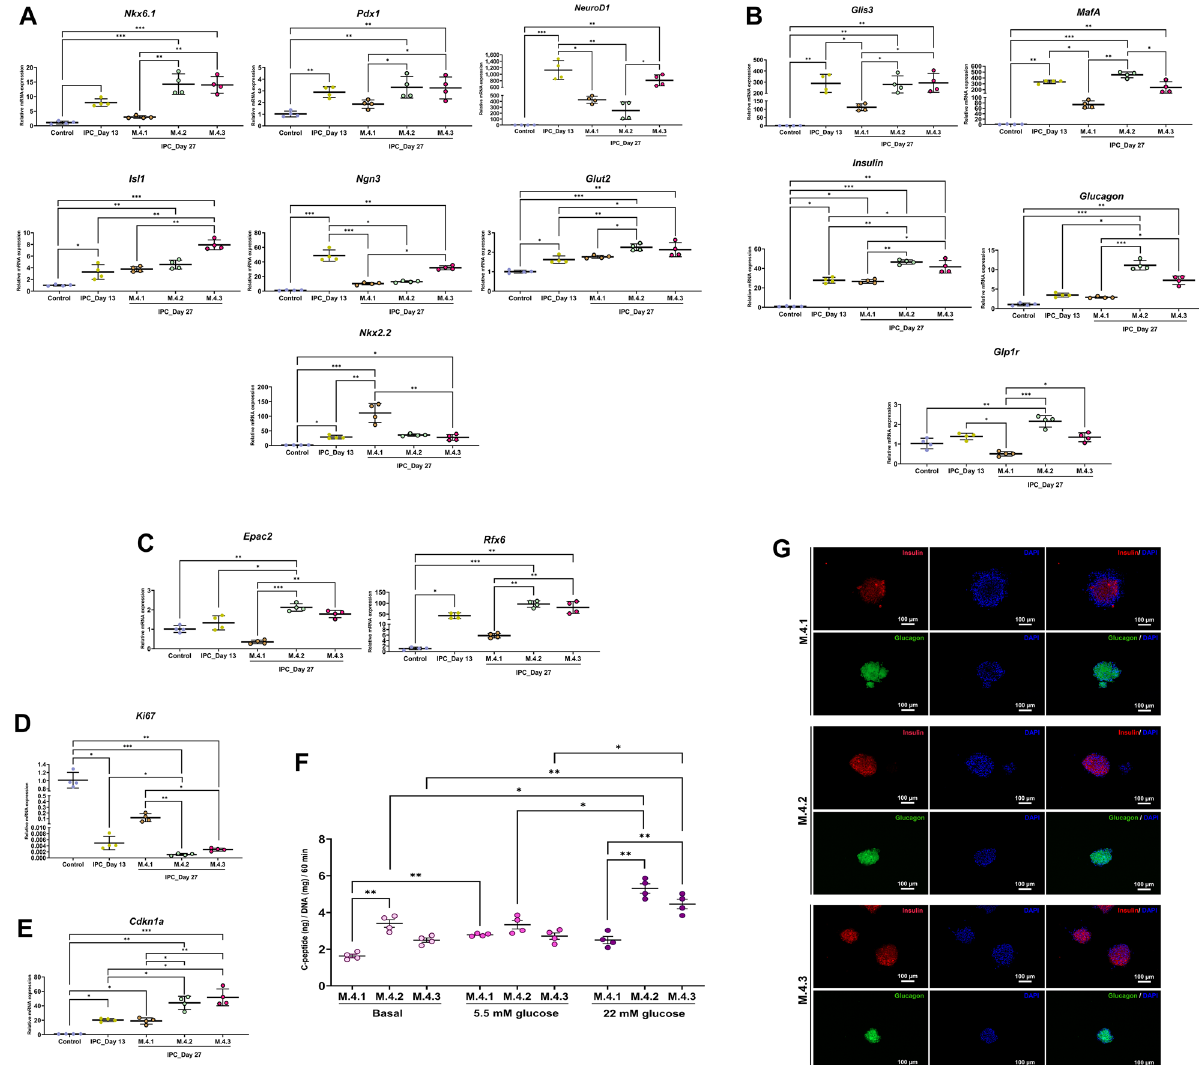
Figure 8. Sustainable functionality of VSCBIC-1 on ALGPA-encapsulated cAD-MSCs-derived IPC maintenance. The expression of mRNA markers relating to PE precursors ( A ), mature endocrine progenitors ( B ), hormone-releasing markers ( C ), a proliferation marker ( D ), and a cell cycle regulator ( E ) was analyzed by RT-qPCR at day 27 post-induction. C-peptide secretion was determined by glucose-stimulated C-peptide secretion (GSCS) assay ( F ). The expression of Insulin and Glucagon by cAD-IPCs was detected on day 27 by immunocytochemistry and observed under fuorescent microscope ZEISS Apotome.2 (Carl Zeiss, Germany) incorporated with Axio Observer Z1 and ZEN pro sofware (ZEISS International, Germany) ( G ). Relative mRNA expression was normalized with the reference gene, and the undifferentiation control. Bars indicates the significant differences (*, p value < 0.05; **, p value < 0.01; ***, p value <